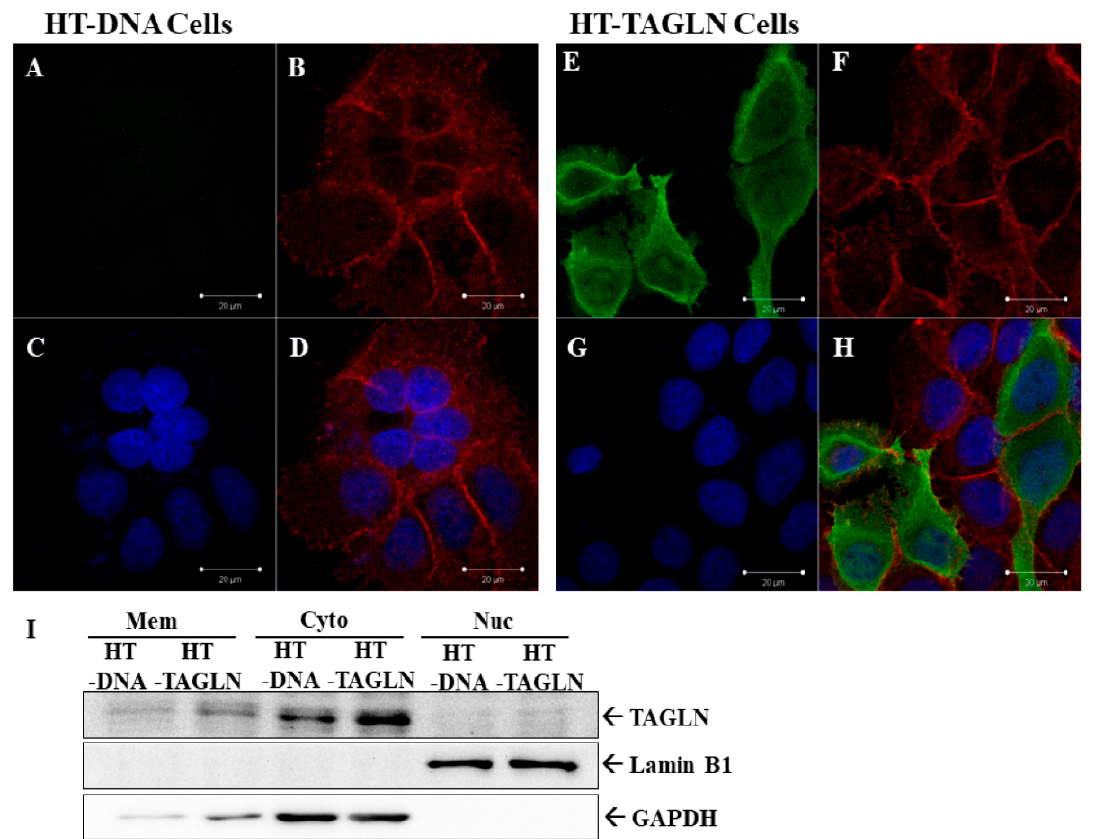
Figure 2. Immunofluorescence staining of TAGLN in TAGLN-overexpressed-HT1376 cells. Immunofluorescence detection of TAGLN in mock-transfected HT1376 (HT-DNA) ( A ) and TAGLN-overexpressed HT1376 (HT-TAGLN) ( E ) cells. The red-stained with Texas Red X-Phalloidin represents the F-actin ( B , F ). The blue-stained by DAPI represents nuclei of cells ( C , G ). All images were observed and recorded under the same settings with a confocal microscope. Immunofluorescence results indicated that TAGLN expression colocalized with F-actin ( D , H ). ( I ) Cells were subcellularly extracted into the membrane (Mem), cytosol (Cyto), and nuclei (Nuc). The protein levels of TAGLN, Lamin B, and GAPDH were determined using immunoblot assays.